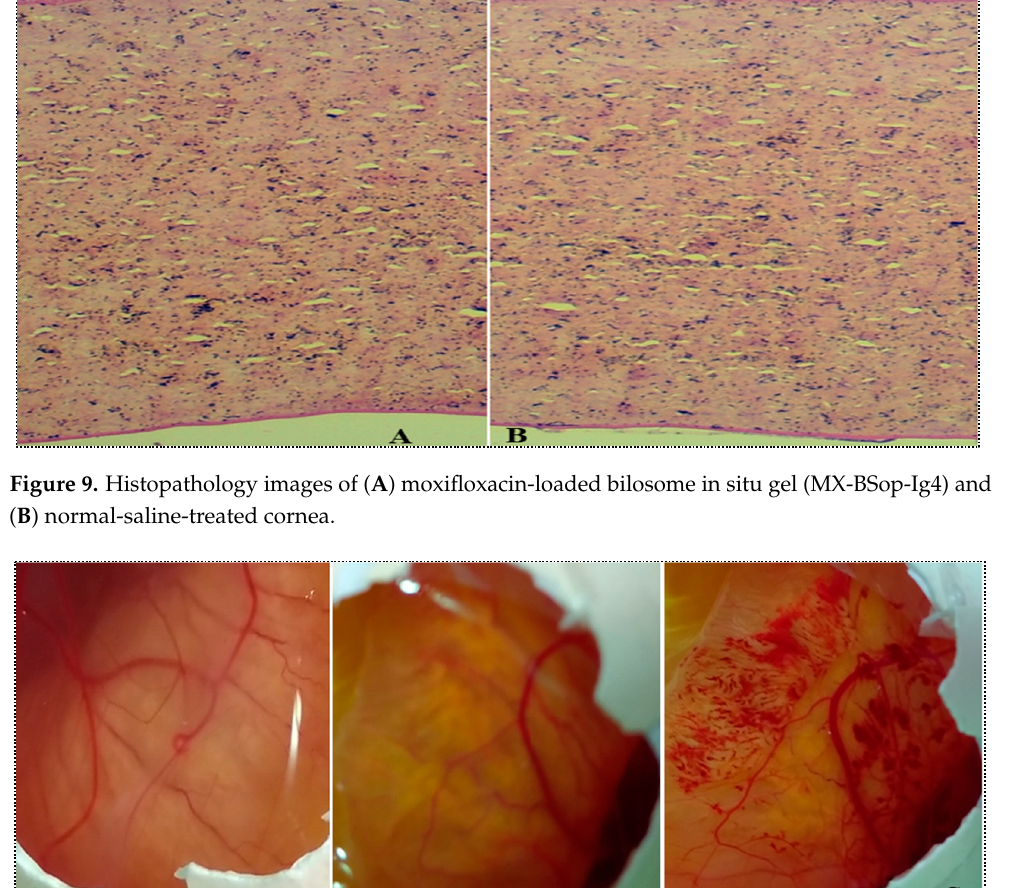
Figure 11. Isotonicity images of ( A ) normal saline and ( B ) moxifloxacin-loaded bilosome in situ gel (MX-BSop-Ig4). 2.4.10. Antimicrobial Activity Evaluation The antibacterial activity of MX-BSop-Ig4 and a pure MX solution was analyzed with zone of inhibition evaluation. The test was performed using the cup-plate method, and the results are depicted in Figure 12. The pure MX (0.5% w/v) solution showed a ZOI of 22.1 ± 1.3 mm against E. coli (Gram-negative) and 26.5 ± 1.7 mm against S. aureus (Gram-positive) at 24 h. The ZOI was decreased at 48 h; it showed 19.3 ± 1.3 mm and 22.8 ± 1.7 mm against E. coli and S. aureus , respectively. The decrease in activity was found to be more pronounced after 48 h. However, MX-BSop-Ig4 exhibited significantly ( p < 0.001) higher antibacterial ac- tivity than the pure MX solution at both time points. At 24 h, the ZOI was found to be 26.5 ± 1.8 mm against E. coli and 27.7 ± 2.2 mm against S. aureus . The activity slightly increased